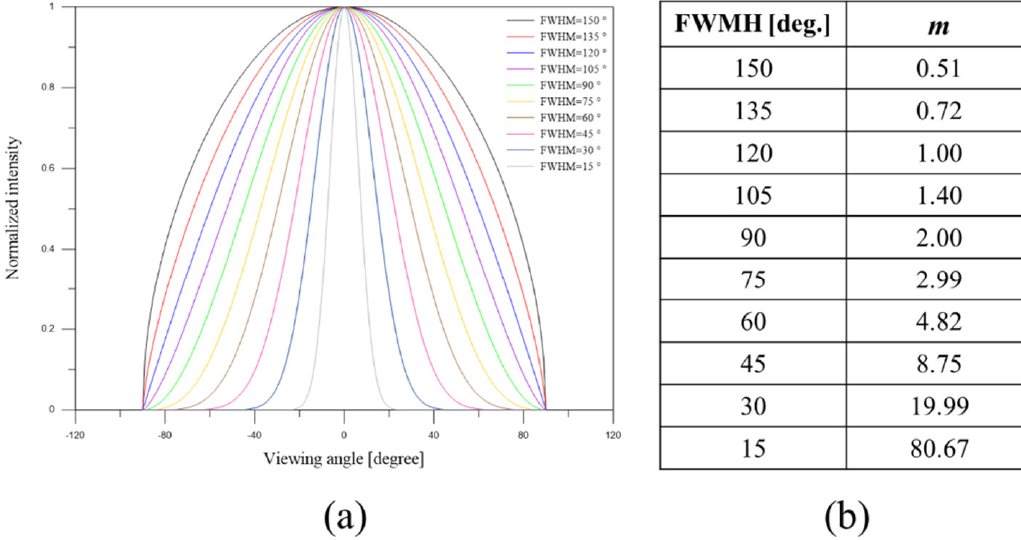
Figure 2. ( a ) Normalized intensity versus viewing angle for different cosine power factor; ( b ) Corresponding table for the cosine power factor versus full width at half maximum (FWHM).